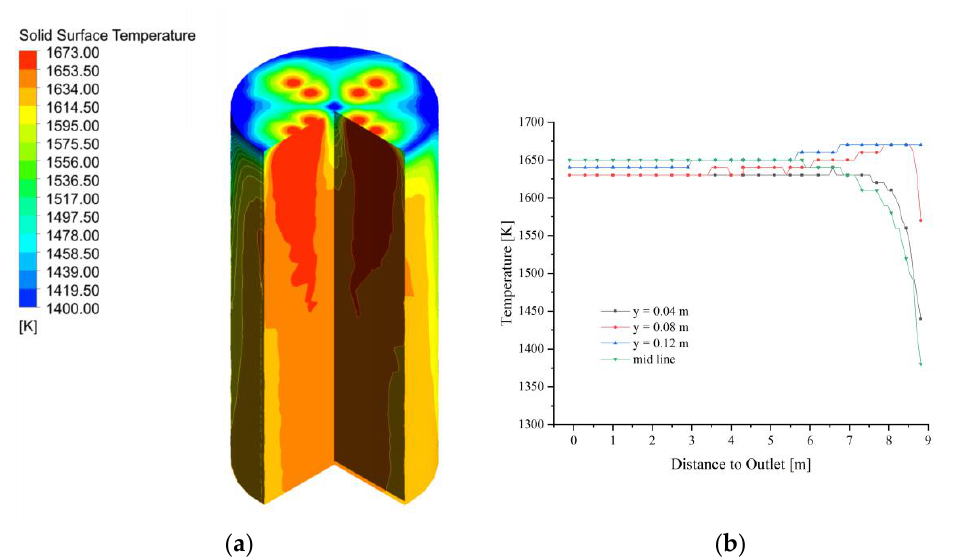
Figure 5. Solid surface temperature field at 40 mm. ( a ) Solid surface temperature; ( b ) Solid surface temperature changes in y = 0.04, 0.08, 0.12 m, and mid line.